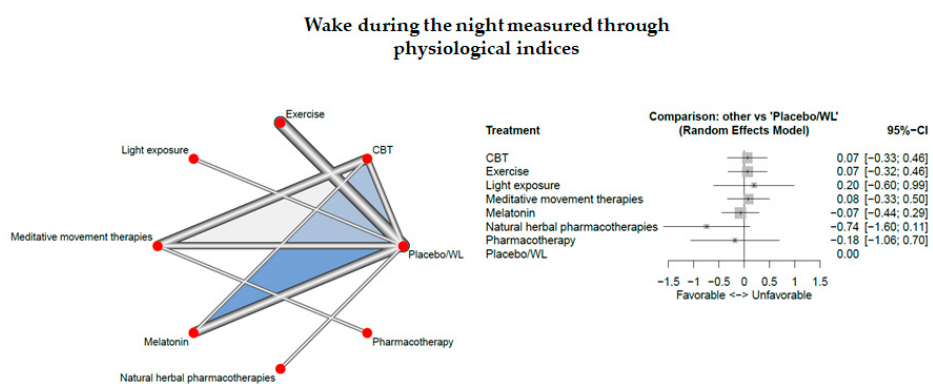
Figure 10. Wake during the night measured through physiological indices .